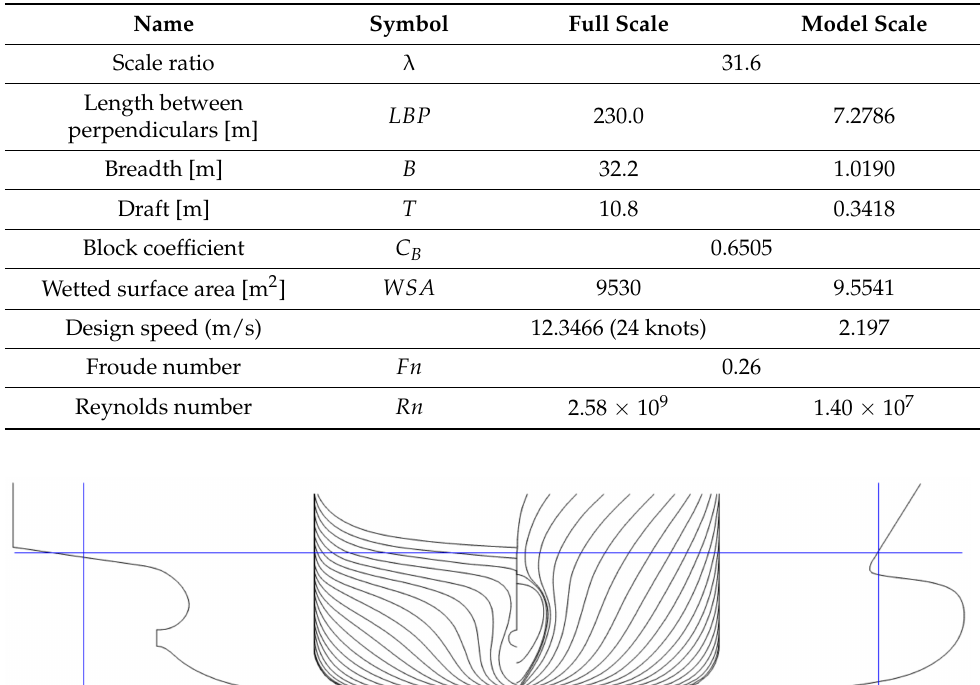
Table 1. Principal particulars of the initial hull form at the sea trial condition.